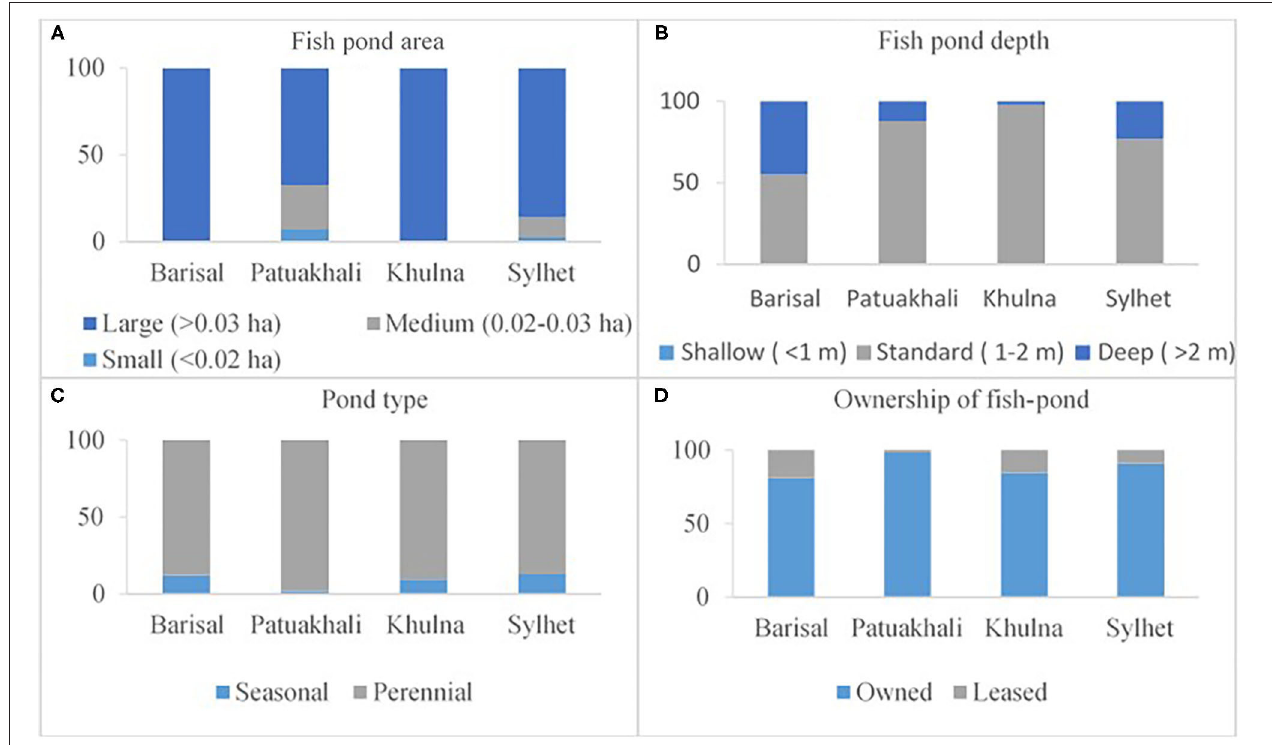
FIGURE 3 | Overview of fishpond information in the studied regions by percent of respondents.